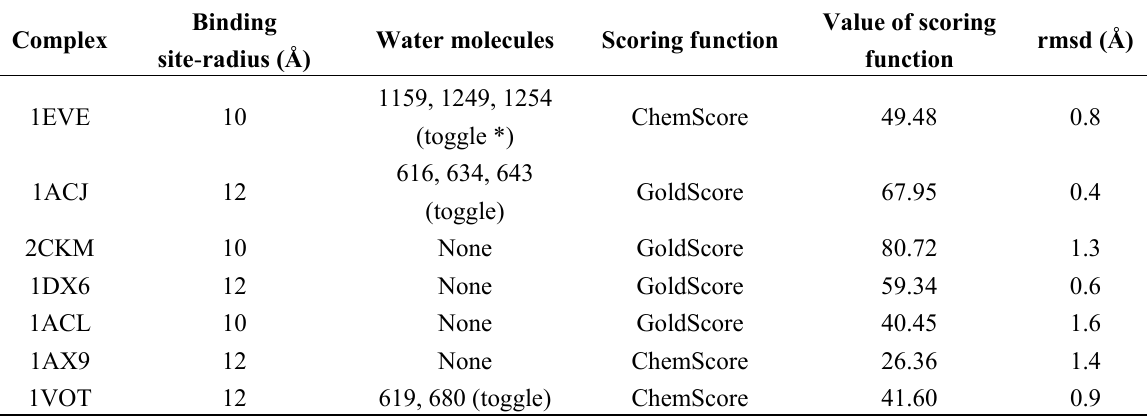
Table 2. Optimal settings of Gold for redockings of seven reference